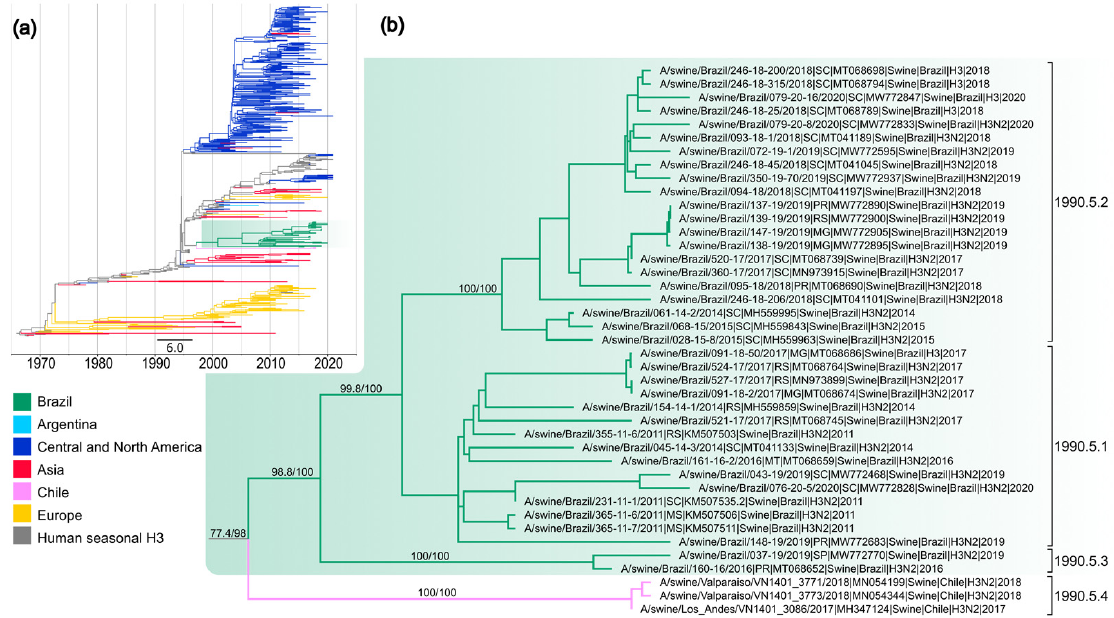
Figure 3. Time-scaled phylogeny demonstrating time of spillover of human seasonal H3 HA segments into swine in Brazil. ( a ) Phylogenetic relationships of the H3 sequences from 393 H3N2 swine influenza virus isolates collected globally during 1969–2021, 94 human seasonal H3N2 influenza viruses collected globally from 1968 to 2021, and 23 vaccine sequences of H3N2 from 1977 to 2020 (total dataset, n = 486 H3 sequences). Gray branches indicate human seasonal influenza viruses. The Brazilian clade is highlighted in green. Branches related to viruses from swine are shaded by country of origin. Branch support values (aLRT/UF boot) > 85 are provided for key nodes. ( b ) In an enlarged subtree of the 1990.5 clade, the genetic clades of H3 segments of H3N2 viruses found in swine in Brazil are identified as listed in Table